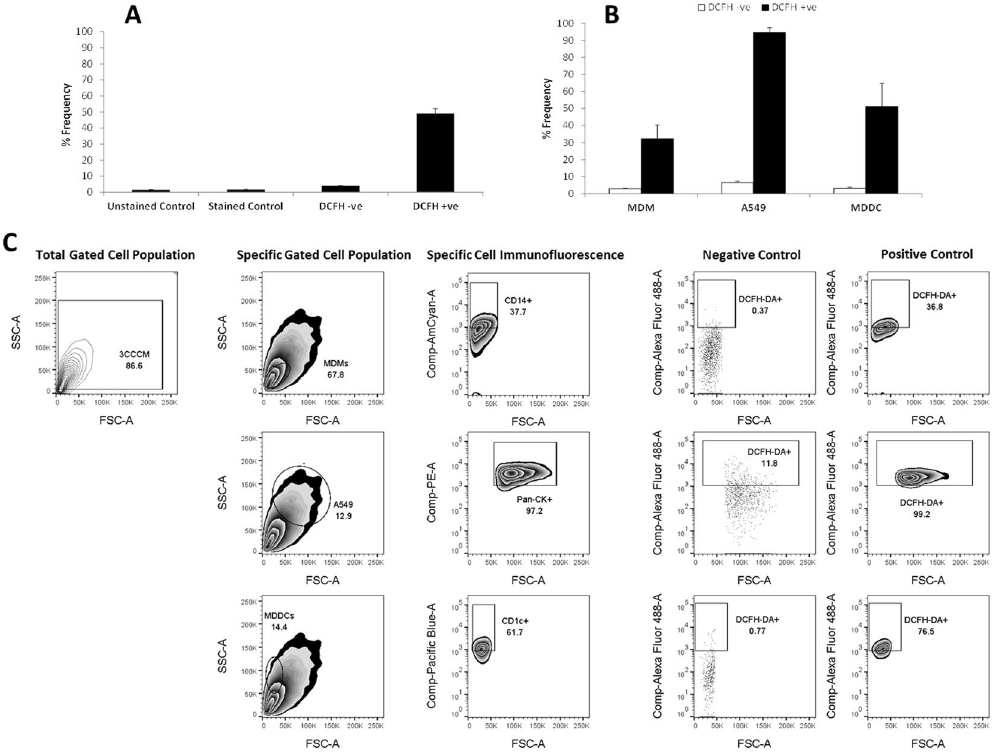
Figure 6. Investigation of the ability to detect the presence of reactive oxygen species (ROS) using the fluorescent probe 2 ′ ,7 ′ -dichlorfluorecein-diacetate (DCFH 2 -DA) ( i.e. the DCFH-DA assay) in the 3D in vitro triple cell co-culture of the human lung epithelial tissue barrier following detachment from micro- porous membrane insert via EDTA-Trypsin treatment. The ROS response was measured for ( A ) the total cell suspension via one-colour flow cytometry (FACS), or ( B ) for each specific cell type of the co-culture system via four-colour FACS. In both ( A and B ), data from one- and four-colour FACS shows the overall ROS response in the co-culture suspension following 4 hours exposure at 37 °C, 5% CO 2 to either complete medium (negative control) or tert -Butyl Hydrogen Peroxide ( t BHP) at [0.04 mg/mL]. Following the exposure period, the co-culture cell suspension was treated with 1:10 dilution of 1 mM DCFH-DA (488 nm). A DCFH-DA treated control (DCFH-ve) was also performed to denote any non-specific fluorescence within the sample. After implementing the specific gating strategy for the co-culture suspension (SI Fig. 1b) ( C ) indicates the gating strategy used to understand a negative and positive response from the multi-cell suspension using the DCFH-DA assay. All data was analysed using FlowJo (Version 10, TreeStar, USA). Data expressed is the mean ± standard error of the mean (SEM) of the %Frequency. In ( A and B ) all data expressed is the mean ± standard error of the mean (SEM). Experimentation was repeated on three separate occasions in triplicate (n =